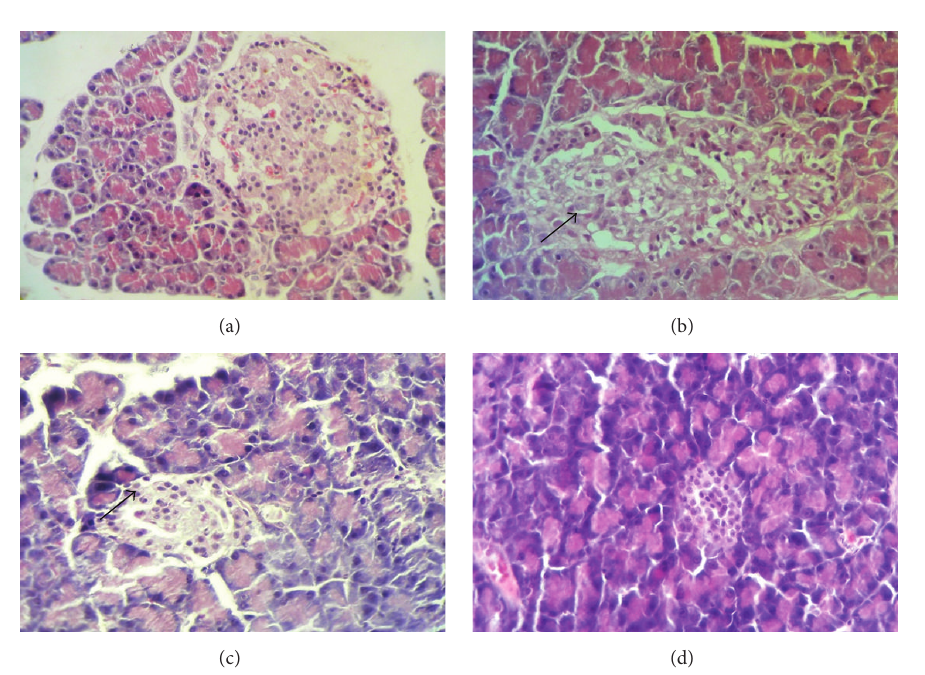
Figure 3: (a–d) Photomicrographs of histopathology of the pancreatic tissues, stained with hematoxylin and eosin ( × 400). (a) Healthy control rats, islets of Langerhans with normal islet cell population. (b) Diabetic control rats, an islet with few preserved islet cells, fibrosis, and infiltration by inflammatory cells. (c) Gmelina arborea (1.00g/kg) treated diabetic rats, restoration of pancreatic islet cells with prominent islets. (d) Glibenclamide treated (0.50mg/kg) diabetic rats with reduced number of islet